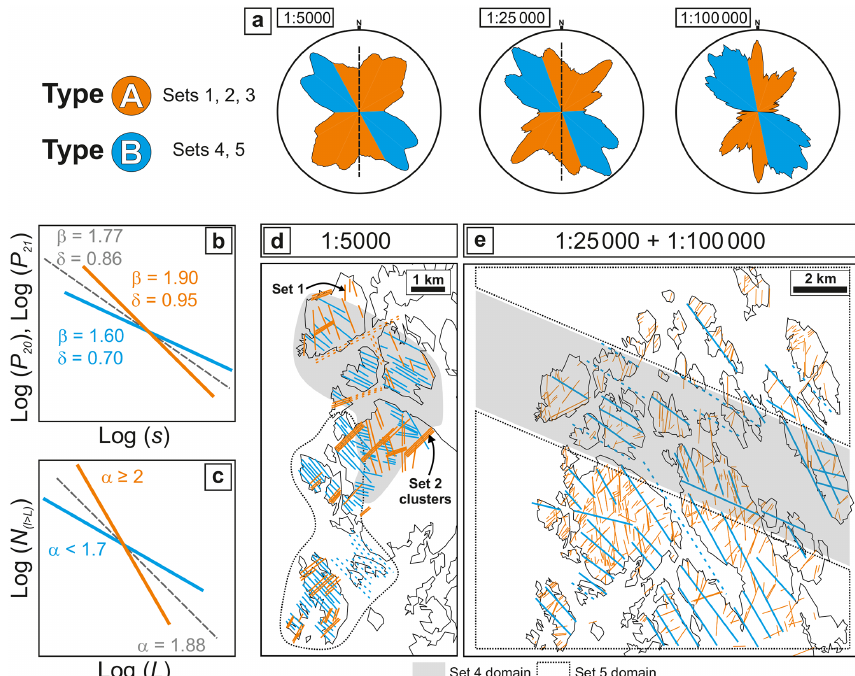
Figure 9. Schematic summary of the results and interpretations for the Rolvsnes granodiorite case study. (a) Rose diagrams of the orienta- tion of lineaments at different scales (1 : 5000, 1 : 25000, 1 : 100000) with the classification into Type A (Sets 1–3) and B (Sets 4 and 5) lineaments. (b) Schematic log-log diagram showing the observed general trends of P 20 and P 21 variations with scale. The values of β and δ exponents are reported for the entire lineament network (gray dashed line) and Type A (orange line) and Type B (light blue line) lineaments. (c) Schematic log-log diagram showing the observed general scaling laws retrieved for the cumulative length distributions. The values of the exponent α are reported for the entire lineament network (gray dashed line), Type A (orange line) and Type B (light blue line) lineaments. (d) Schematic representation of the lineament distribution at 1 : 5000 scale. The reported lineaments are redrawn from the 1 : 5000 lineament map and represent the spatial organization observed within the Rolvsnes granodiorite. (e) Schematic representation of the lineament distri- bution at 1 : 25000–1 : 100000 scales. The reported lineaments are redrawn from the 1 : 25000–1 : 100000 lineament maps and represent the spatial organization mapped on the Rolvsnes granodiorite. Note the clustered organization of Set 2 lineaments and the two domains (highlighted by transparent gray and dashed areas) where Set 4 and 5 lineaments are